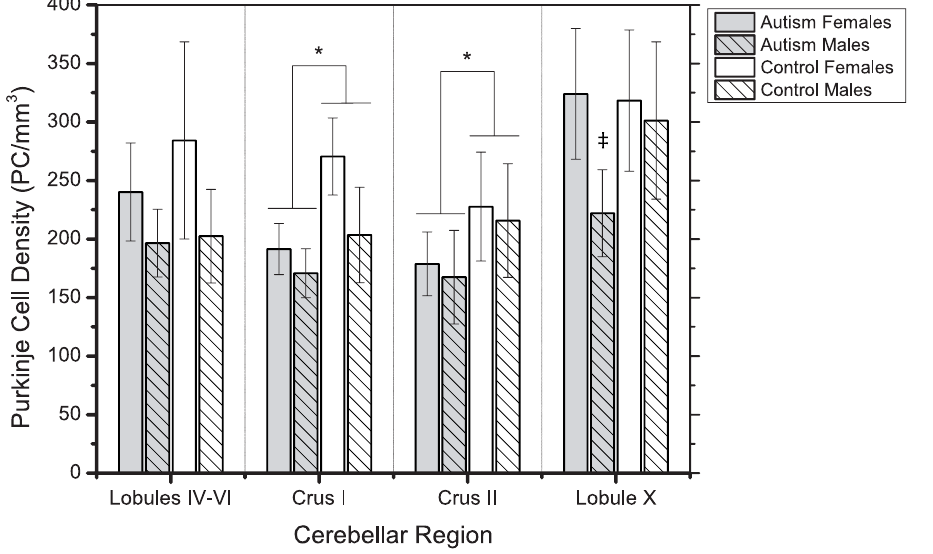
Figure 3. Regional PC Density. This graph demonstrates the findings from our linear mixed models (Table 2). Mean PC density was lower in the autism group in each region assayed, but this finding was most prominent in crus I and II (marked with * ), where there was 19.8 6 9% and 21.7 6 9% lower PC densities, respectively (p=0.039 and p=0.032, t-test). (See the results of this test in Table 3). Lobule X PC density was lower in the males with autism (marked with ` ) than in control males (p=0.05), and lower than female cases in the autism group (p=0.022). Bars represent mean 6 standard deviation. The number of subjects for each test from each diagnostic group and their gender are represented in the results tables (Tables 2 and 3).